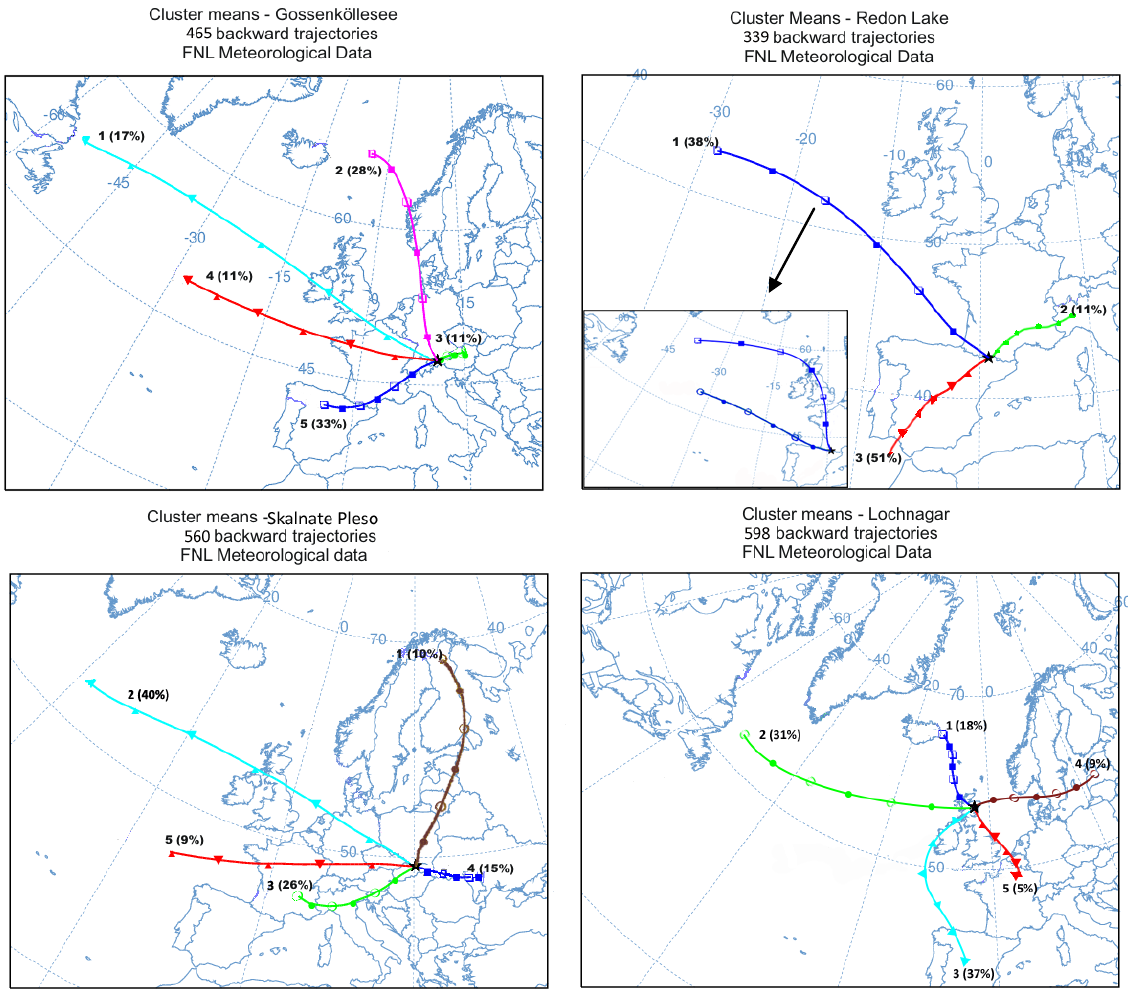
Fig. 1. HYSPLIT 72h back trajectories to the studied sites. Values in parenthesis showed total contribution of each trajectory during the entire sampling period. Table 3. Mean depositional fluxes, range, and frequency of detection (FD) of BDE congeners in bulk atmospheric deposition to high mountain regions of